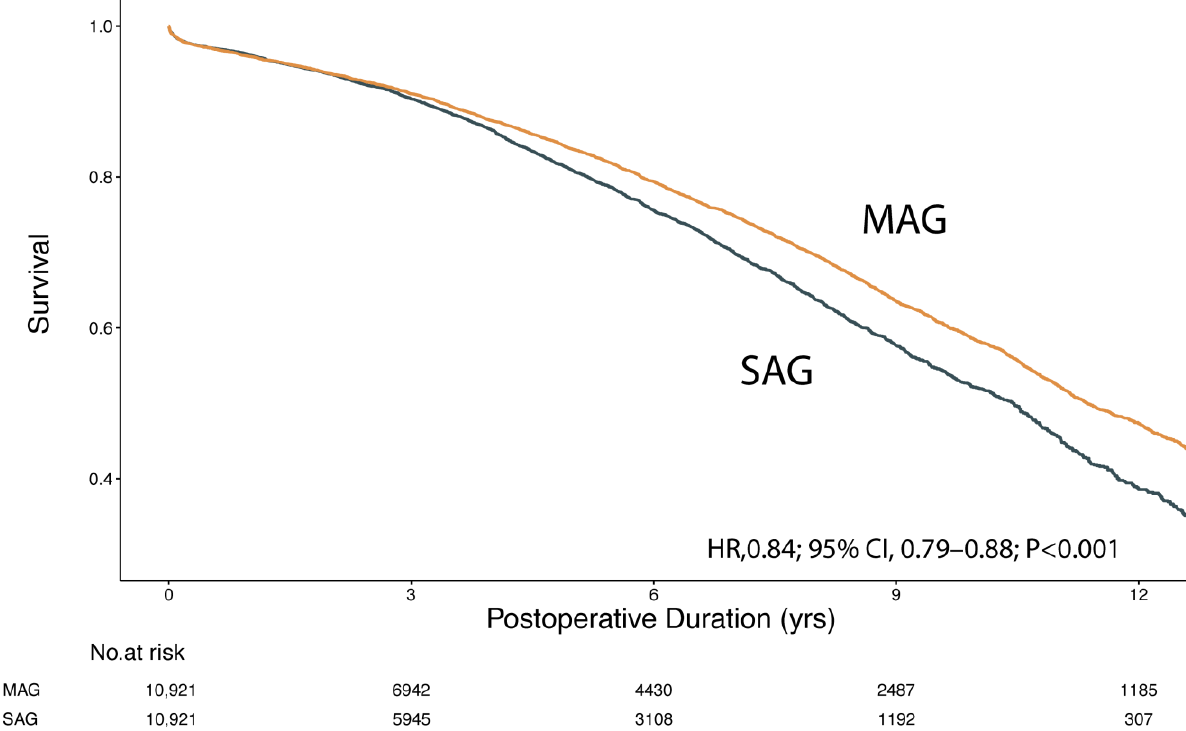
Figure 3. Kaplan–Meier survival curve for MAG vs. SAG in matched cohort ≥70 years of age. MAG, multiple arterial grafting; SAG, single arterial grafting.